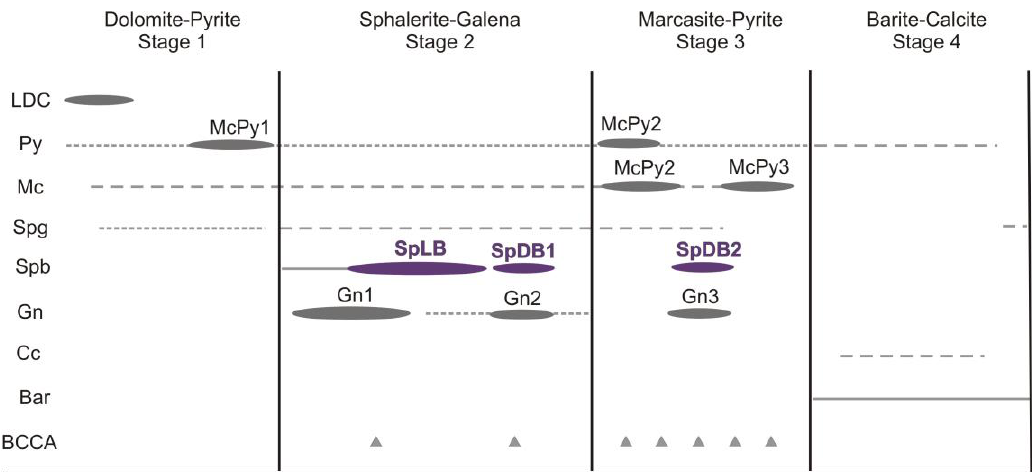
Figure 5. Typical massive sphalerite-galena-marcasite ore from the Mississippi Valley-type (MVT) deposits in the Silesia-Cracow district. ( A – E ) Characteristic colloform Zn-Pb-Fe ore composed of cryptocrystalline (rhythmic or botryoidal) sphalerite (SpLB1, SpDB2 for explanation see Figure 4), rod-like fibrous marcasite (McPy2), and coarse crystalline or metacolloidal galena (Gn1, Gn2). The Olkusz ( A , C ) and Trzebionka ( B ) mines; ( D ) ore-bearing dolomite (OD) with colloform Zn-Pb-Fe ore represented by sphalerite (SpLB1, SpDB2)-marcasite and coarse crystalline galena (Gn2); Pomorzany mine ( E ) massive crystalline marcasite pyrite (McPy2) with sphalerite (SpDB2) and galena (Gn2) coatings; and the Pomorzany mine ( F ) brecciated ore-bearing dolomite (OD) cemented by dark brown sphalerite (SpDB2), the Trzebionka mine.